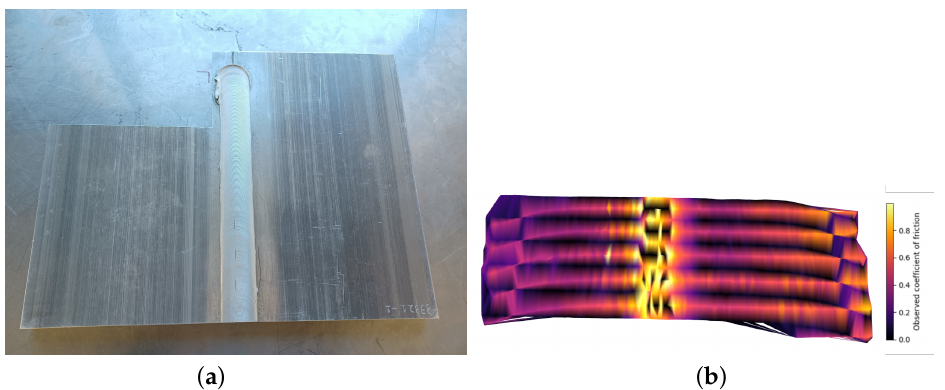
Figure 10. Friction analysis of a friction-stir weld shows that measuring the surface-friction can indicate discontinuities in the surface. The upper section presented a sharpened lip, avoided for the safety of the wedge. ( a ) Colour image of the welding plate. The lower half of the plate was scanned as part of this analysis. ( b ) Friction coefficient encountered as a heat-map over the surface. The accuracy of the frictional values is determined by the size and shape of the wedge’s surface—in this case, 25 × 25 mm.